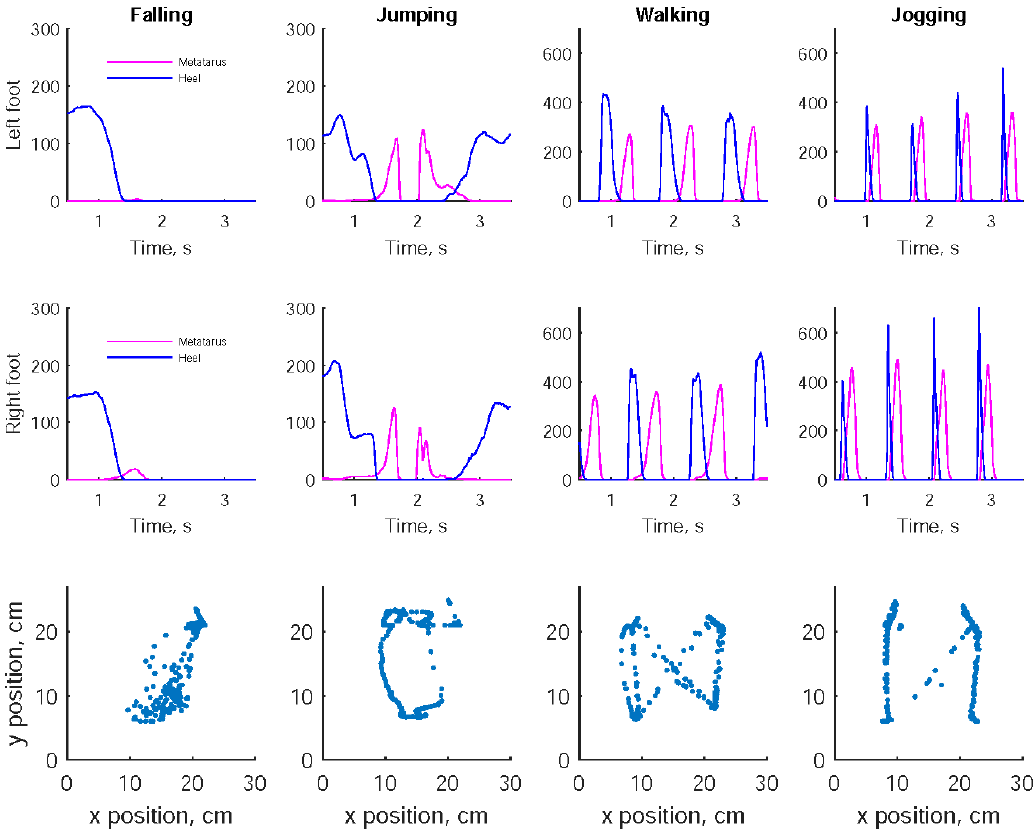
Figure 3. Relative foot pressures at the metatarsus, heel areas, and center of plantar pressure while a subject was undertaking a forward fall, a jump, a forward walk, and a forward jog.